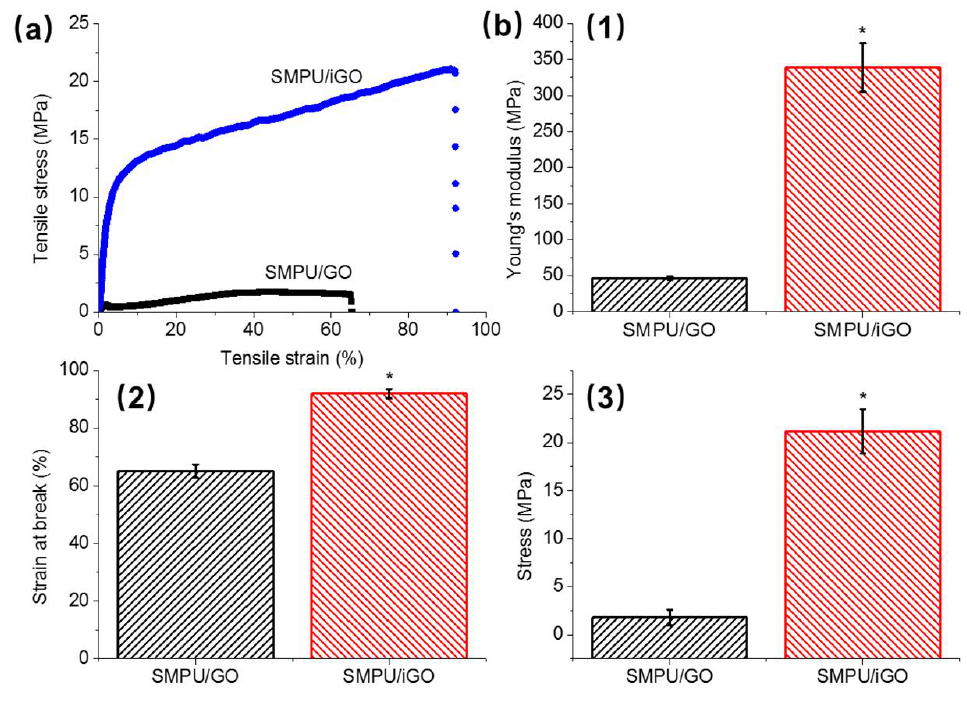
Figure 3. Mechanical properties of the SMPU/GO and SMPU/iGO: ( a ) tensile curves; ( b ) Young’s modulus, ( 1 ) strain at break, ( 2 ) and stress ( 3 ) derived from ( a ); *, significant difference compared to SMPU/GO, p < 0.05.